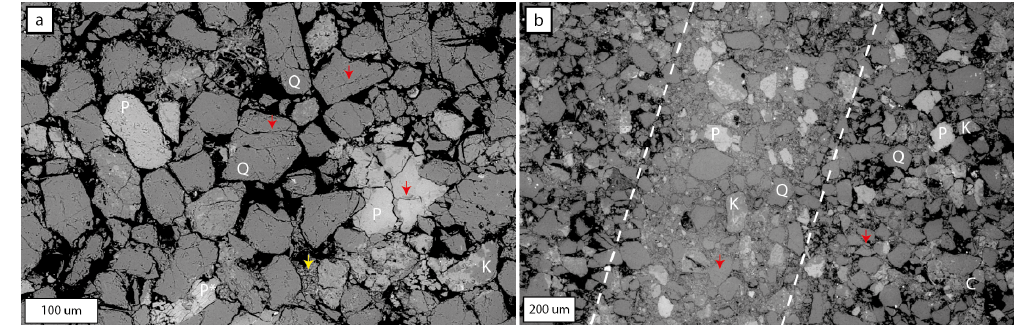
Figure 8. BSE images of D2 normal-sense compactional shear bands and associated host rock. (a) A normal-sense compactional shear band hosted within less deformed host rock. The white dashed lines indicate the edge of the deformation band. Deformation bands associated with D2 horizonal extension have diffuse edges and are characterised by reduced porosity and an increased clay content. The red arrows denote the location of microfractures. Microfractures are observed in grains within the deformation band and within the host rock. The host rock is characterised by higher porosity compared with the deformation band. Panel (b) is an image of host rock sampled within 5cm of a normal-sense deformation band. Within the host rock, microfractures are present, with some examples highlighted by red arrows. In addition, pockets of smaller grain size can be seen with higher clay content, indicating the lithological heterogeneity of the unit. Such an example is indicated by the yellow arrow. Q denotes quartz, C denotes zones of clay-sized particles, K denotes potassium feldspar, P denotes plagioclase, and P ∗ denotes deformed plagioclase.